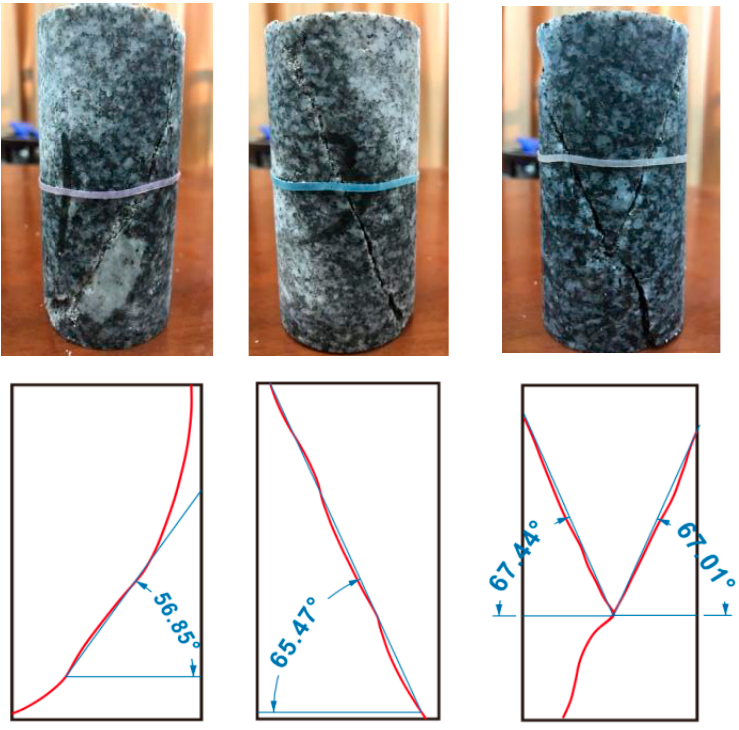
Figure 12. Test results and failure modes of granite with confining pressure at 15 MPa. Figure 13 shows the failure diagrams for confining pressures at 20 MPa. The specimen was initially in a quiet period for longer than the other cases. The specimen